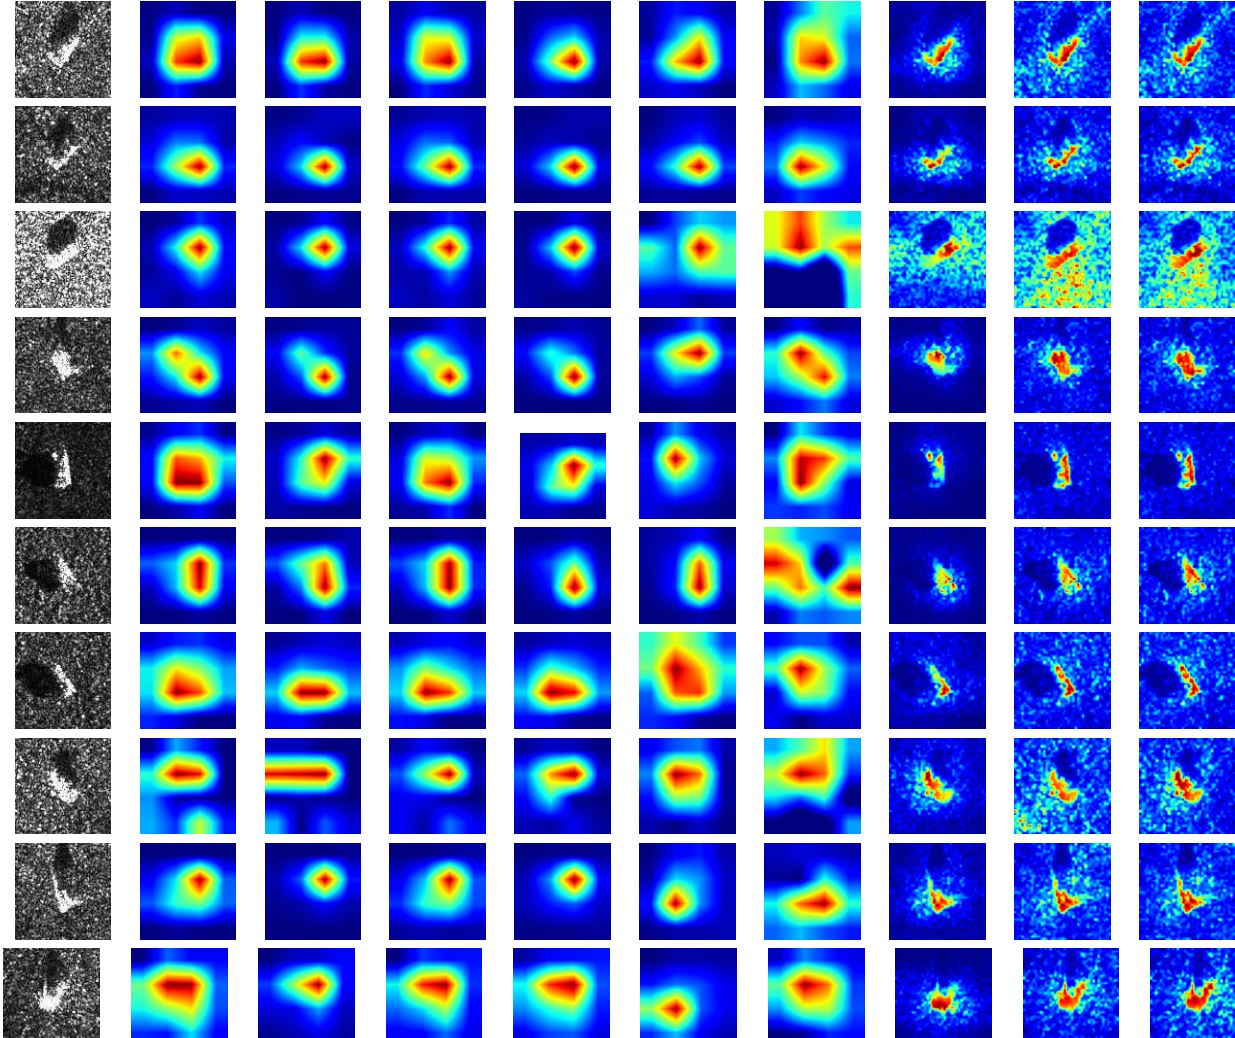
Figure 2. Comparison of various CAM methods for MTSTAR SAR images. The ten rows denote vehicles of different classes: 2S1, BRDM_2, BTR_60, D7, SN_132, SN_9563, SN_C71, T62, ZIL131, and ZSU_23_4. The ten columns denote original SAR image, Grad-CAM, Grad-CAM++, XGrad-CAM, Ablation-CAM, Score-CAM, Group-CAM, Self-Matching CAM, G-SM-CAM and SC-SM